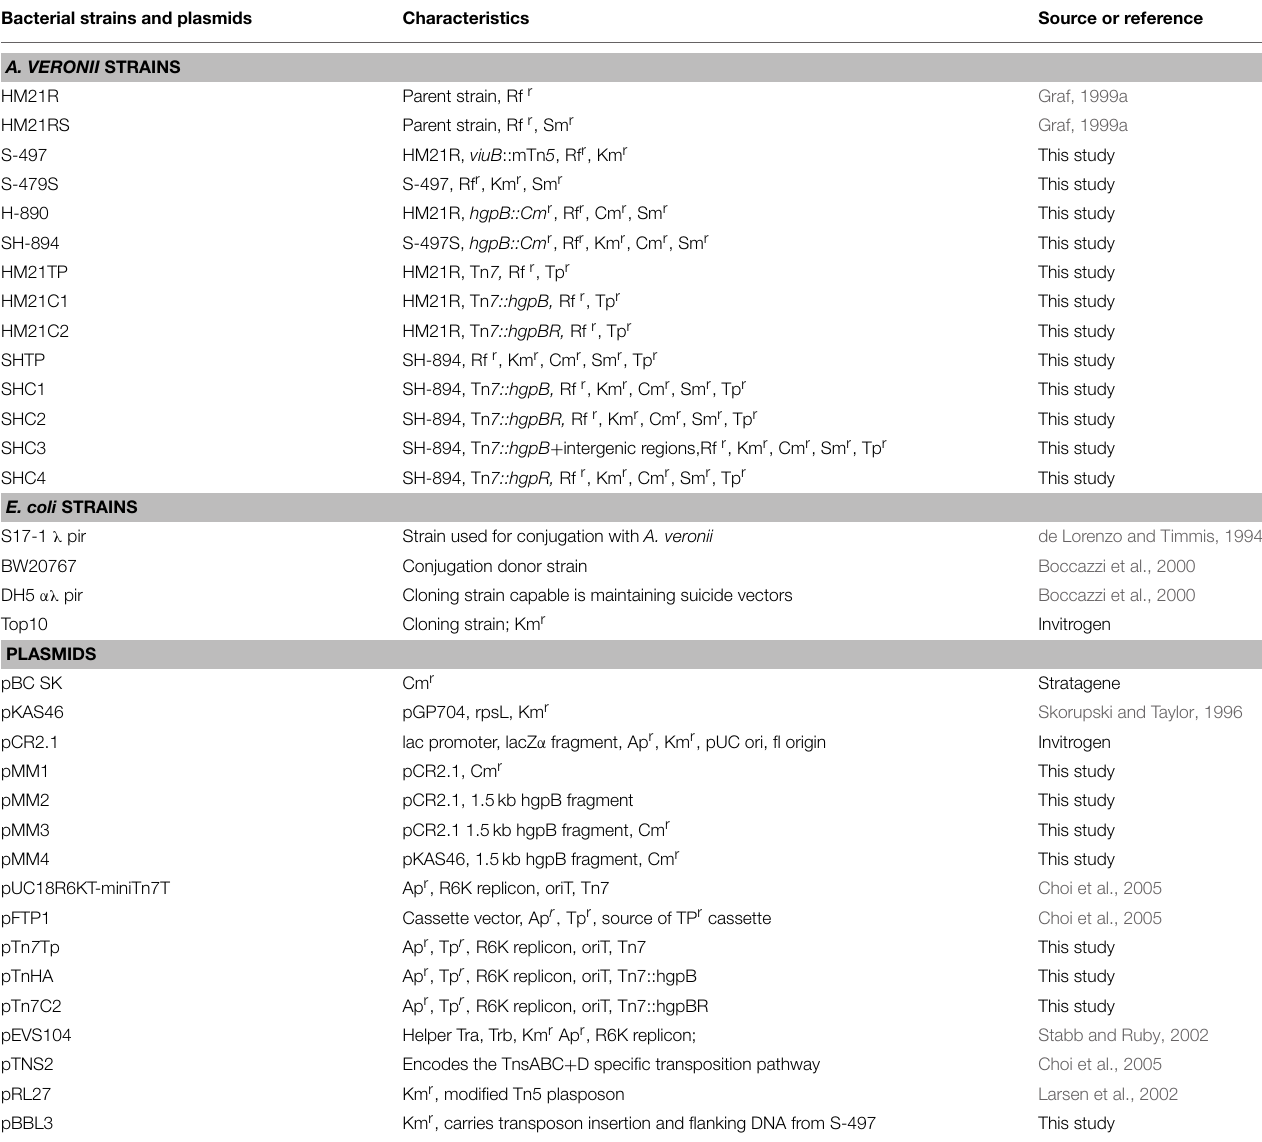
TABLE 1 | Bacterial strains and plasmids. Bacterial strains and